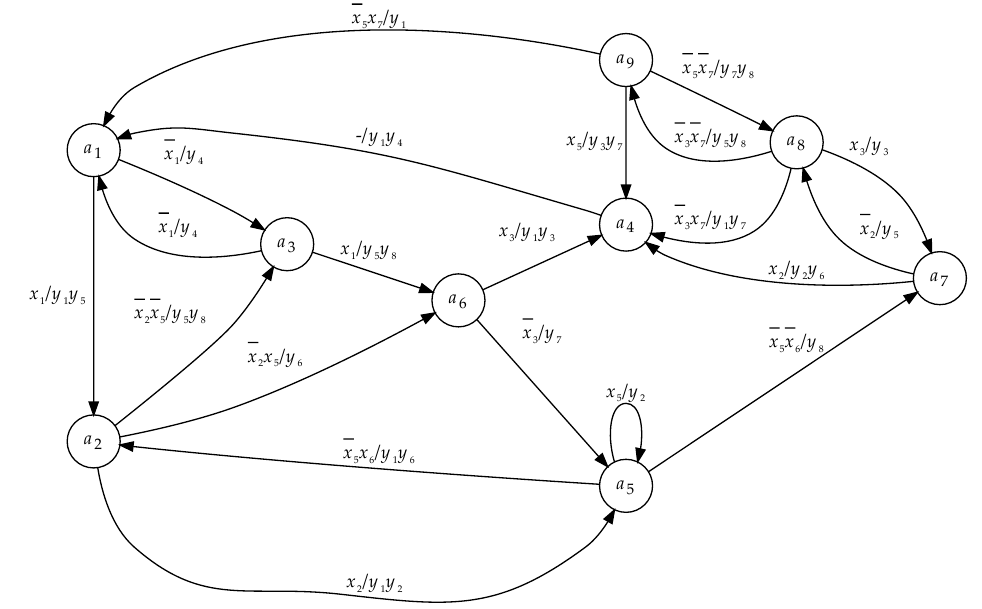
Figure 5. State transition graph of Mealy FSM S 1